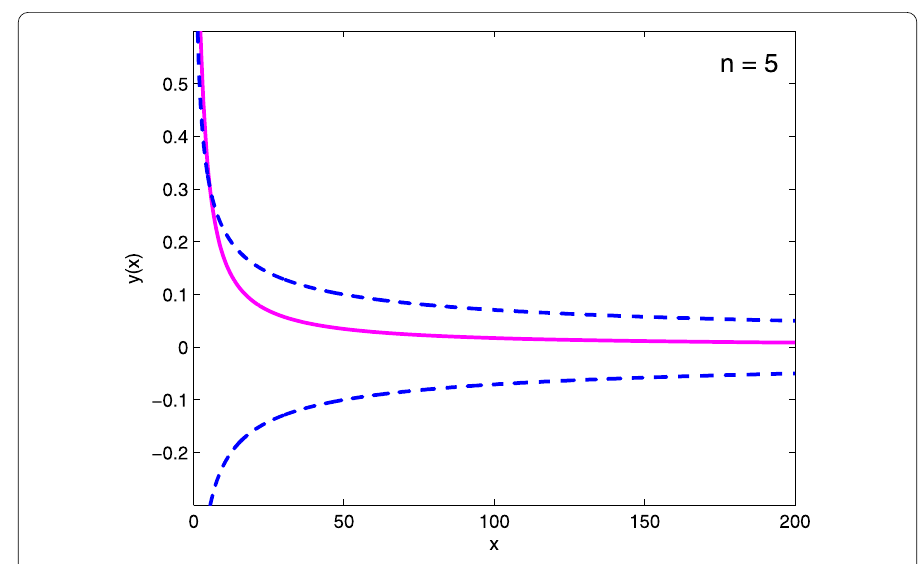
√ Figure 4 The known analytical solution y = 1/ 1 + x 2 /3 [10] of the spherical equation (8) with D = 3, n = 5, and boundary conditions y (0) = 1 and y (cid:2) (0) = 0. The solution enters and stays in the region between √ 2 x where it cannot oscillate. The upper dashed curve y + also represents the the dashed curves y ± = ± 1/ singular solution (15) with n =